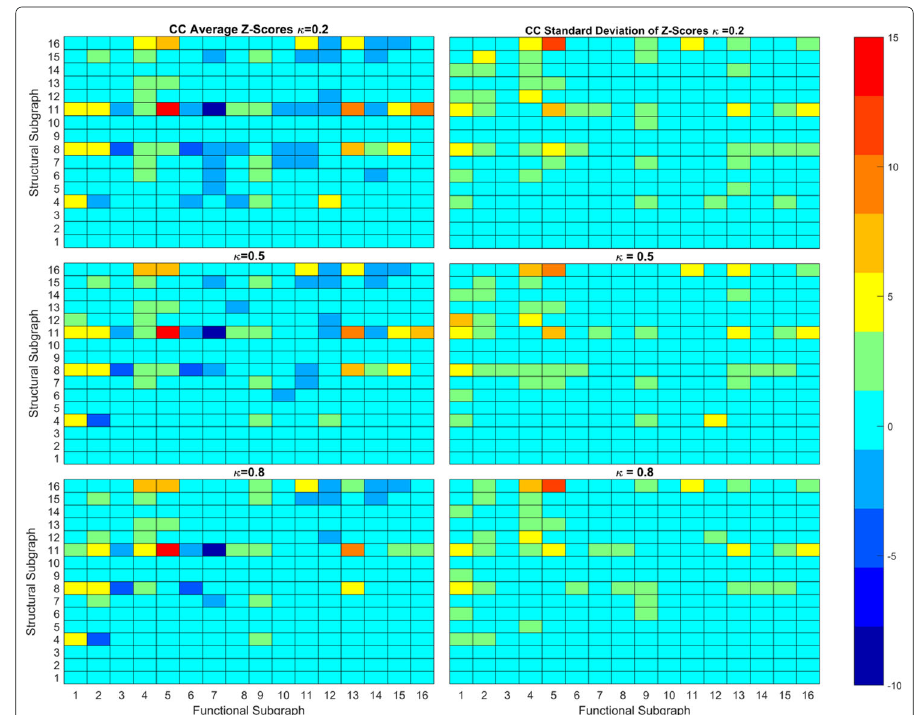
Fig. 9 Average and Standard Deviation of Z-Scores for CC. Heatmap of average and standard deviation Z-scores of triadic subgraphs for TE reconstruction